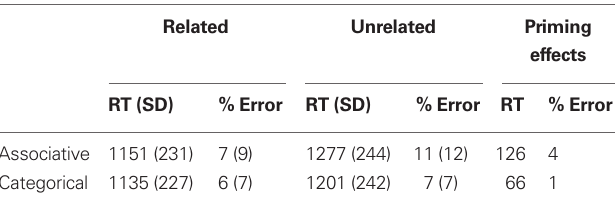
Table 1 | The mean response times in milliseconds for correct responses (SD in brackets), and error rates in experiment